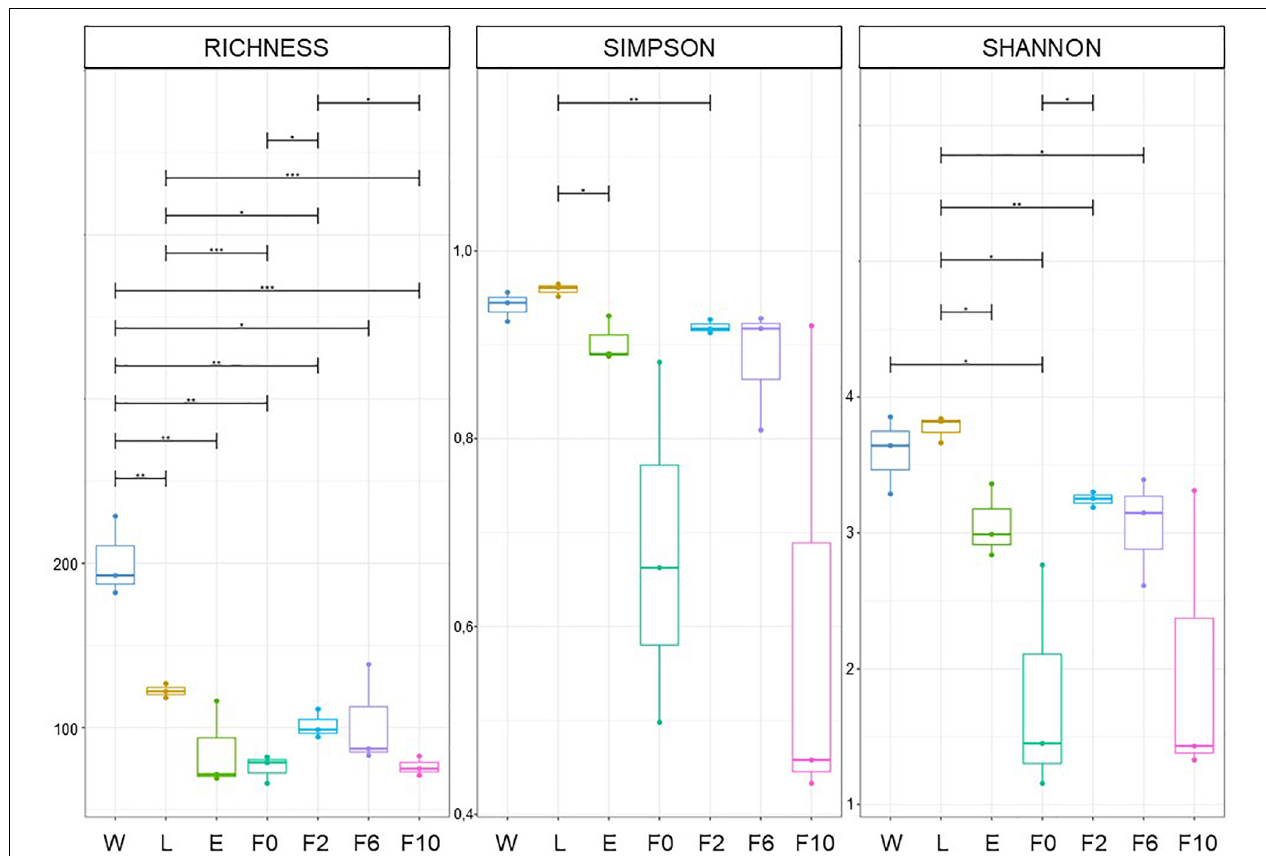
FIGURE 1 | Differences in bacterial community structure. OTU richness and Simpson and Shannon indices estimated at family level. Sample types: W, breeding water; L, larvae; E, newly emerged females; F0, wild-caught females; F2, F6, and F10, laboratory-reared females from the second, sixth, and 10th generations, respectively. Boxes represent the interquartile range within each group. The line that divides the box corresponds to the median and dots, to minimum and maximum scores. Analysis of variance (ANOVA) significance levels: * p = 0.01–0.05; ** p = 0.001–0.01; *** p < 0.001.